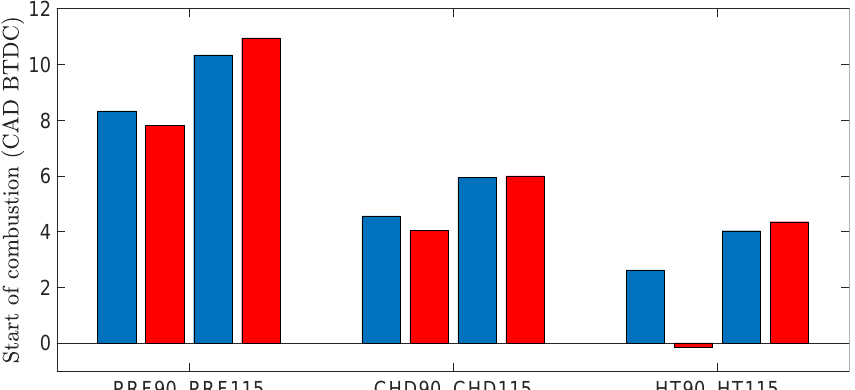
Figure 13. Start of combustion determined from combustion pressure (blue) and optically (red) for the three fuels at the two T inlet considered.